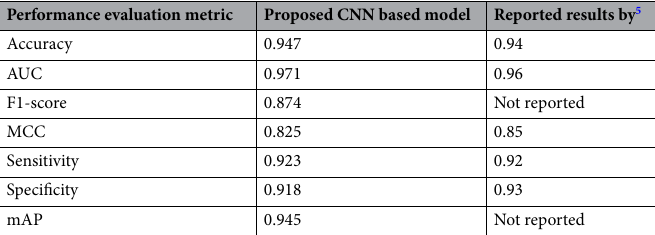
Table 1. Comparison with available